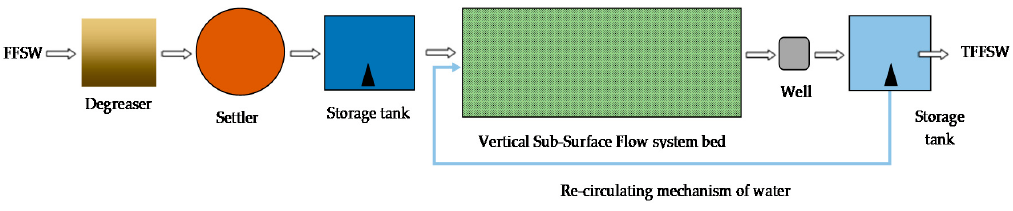
Figure 2. Layout of the first-flush stormwater (FFSW) treatment plant at ExpA_1.